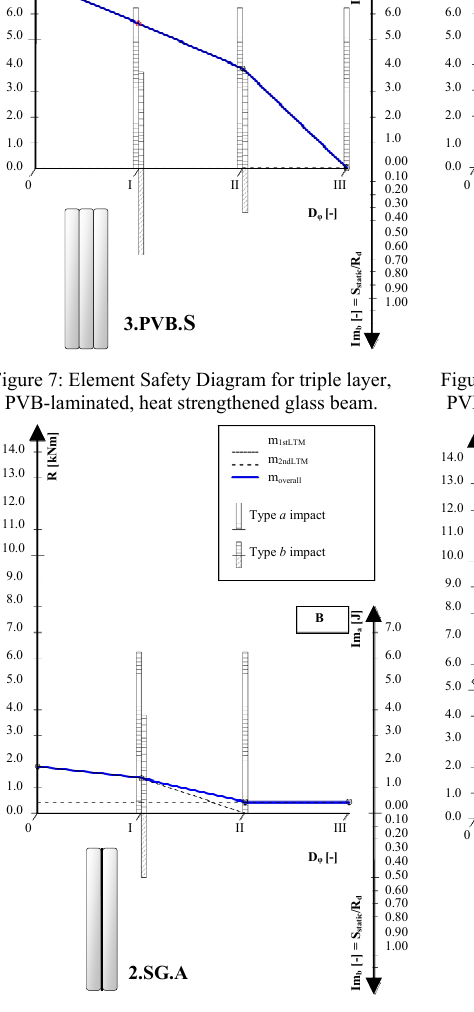
Figure 9: Element Safety Diagram for double layer, SG-laminated, annealed glass beam.